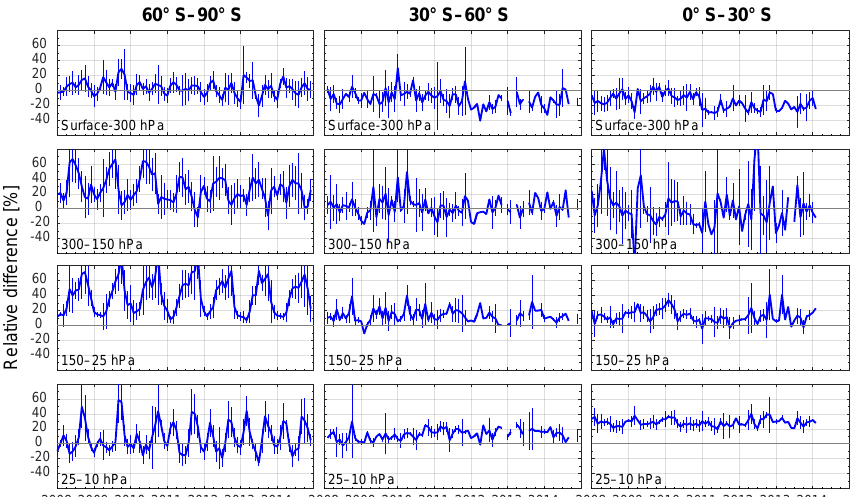
Figure 16. Same as Fig. 15 for the Southern